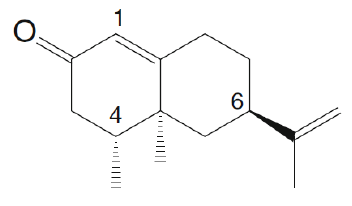
Figure 1. ( + )-Nootkatone (NTK) [8]. Figure 1. (+)-Nootkatone (NTK) Figure 1. (+)-Nootkatone (NTK) [8].